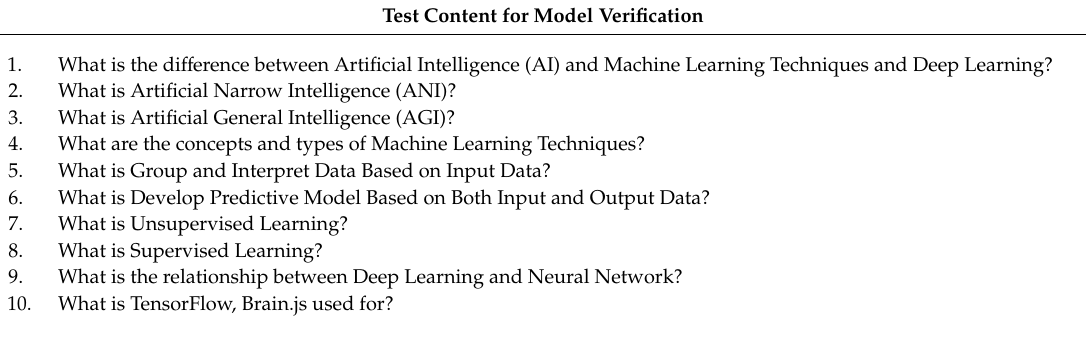
Table 6. Research instrument for model